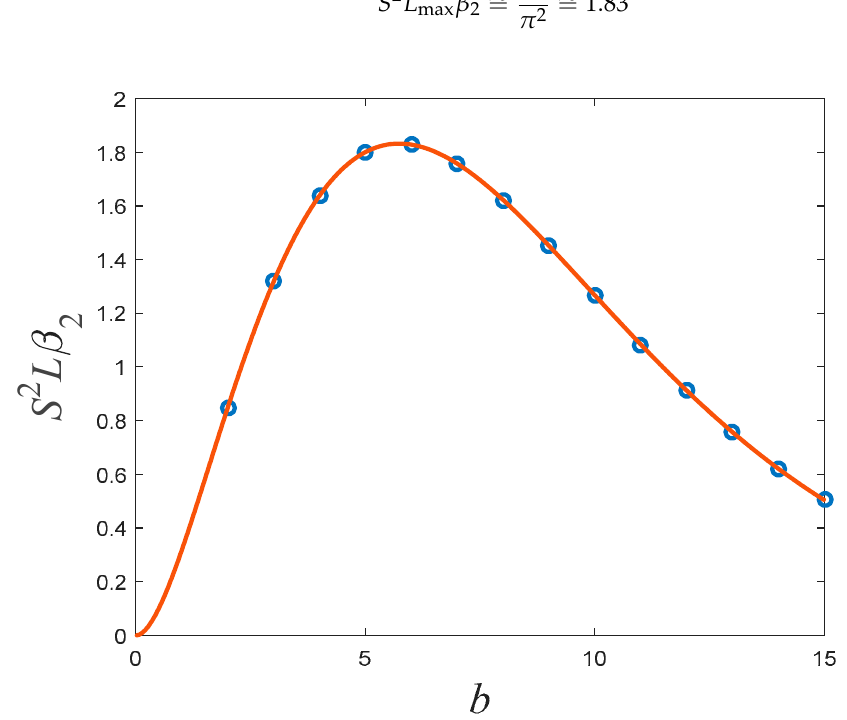
Figure 6. Product S 2 L max β 2 as function of number of bits per symbol b .